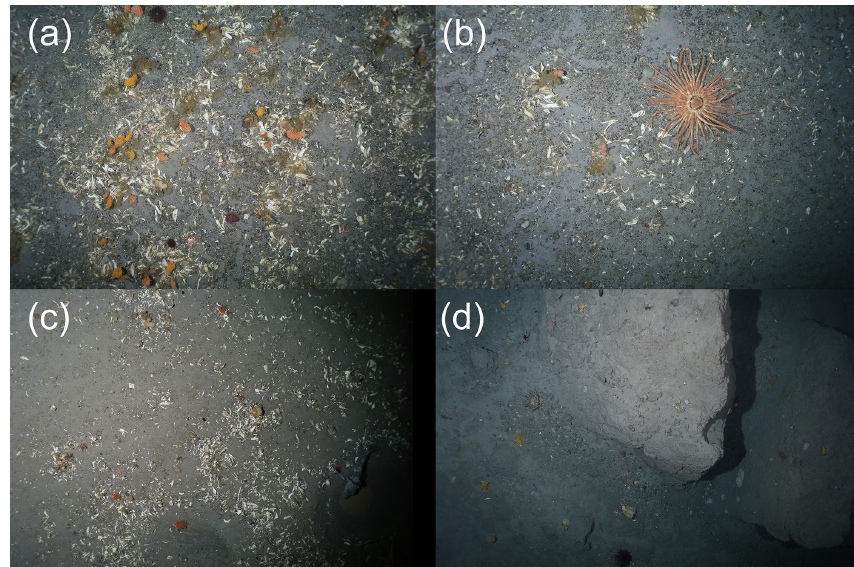
Figure 5. Typical seafloor images collected from each of the OFOBS surveys made of the western Filchner Shelf seafloor during RV Po- larstern cruise 124. All images were taken during deployment PS124_37-6. (a) SW_RELEASER_2021_02_21 at 01_36_51 IMG_0127.JPG, (b) SW_RELEASER_2021_02_21 at 01_37_28 IMG_0130-JPG, (c) SW_RELEASER_2021_02_21 at 02_44_44 IMG_0336.JPG, (d) SW_RELEASER_2021_02_21 at 03_56_56 IMG_0579.JPG. The three red points within each image represent the sizing lasers (50cm spacing). All images are presented here and in the dataset with no manipulation or colour correction.